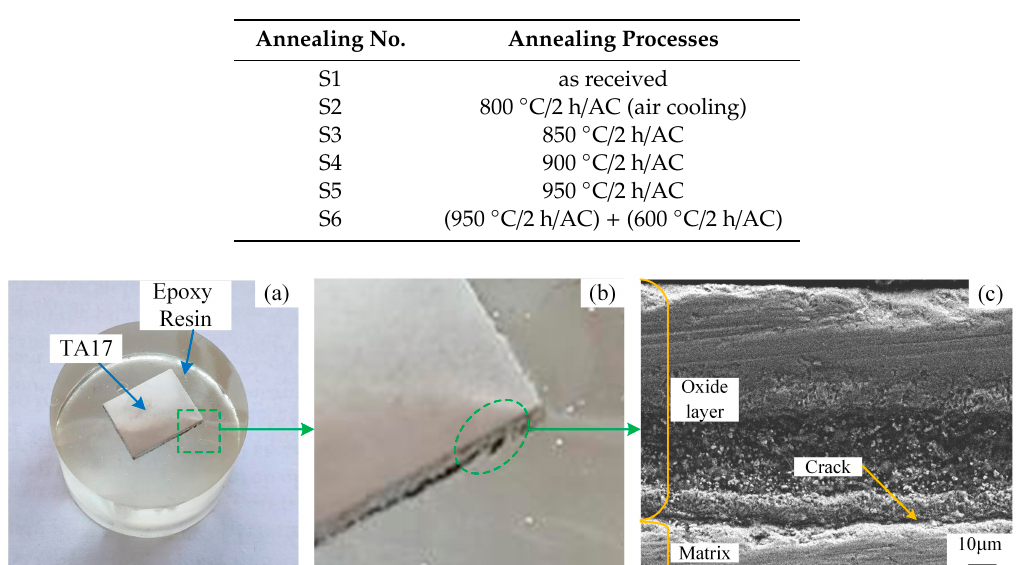
Table 2. The designed annealing process for TA17 sheets.